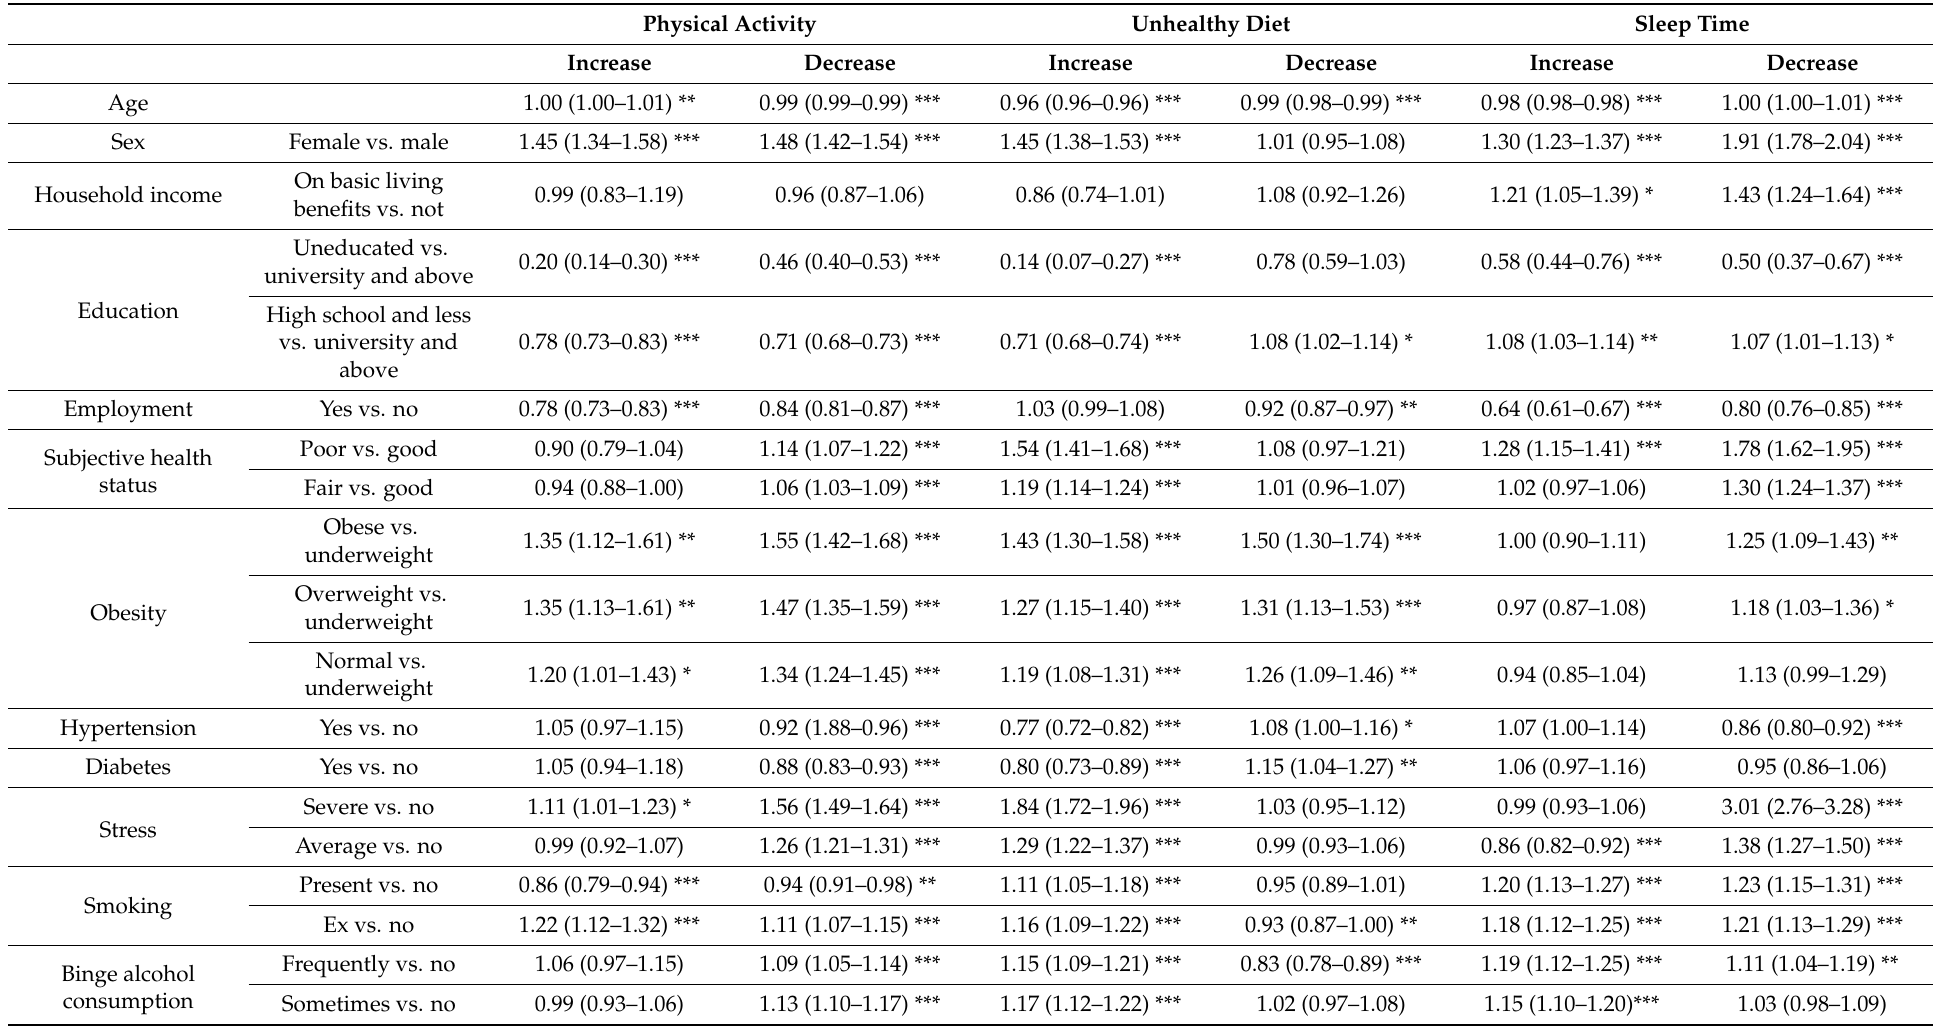
Table 4. The influence of participant characteristics on changes in health behaviors during the COVID-19